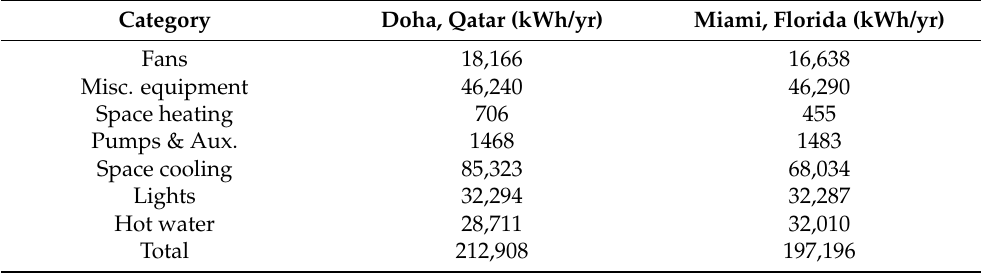
Table 3. Annual energy requirements for case study building from Green Building Studio